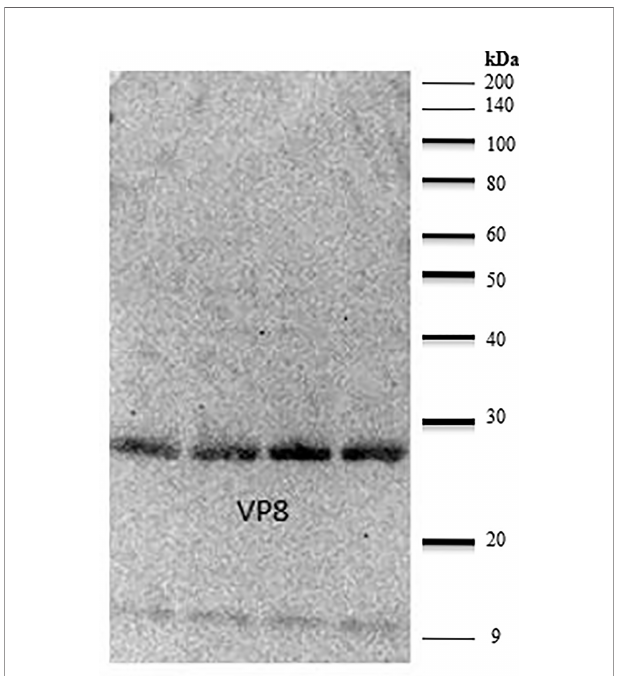
FIGURE 3 | Anti-VP8 chicken antiserum detects recombinant VP8 in a Western blot. Lanes 1-4 were loaded with 5µg of puri fi ed recombinant VP8, separated by SDS-PAGE and transferred to a PVDF membrane. The membrane was blocked in 2% BSA. Puri fi ed, biotinylated chicken anti-VP8 antibody served as the primary antibody (1:3,000) and streptavidin conjugated HRP was used to detect (1:10,000). Lanes 1-4 were loaded with 5µg of puri fi ed recombinant VP8. The puri fi ed, biotinylated chicken anti-VP8 antibody recognized the 28 kDa protein at a dilution of